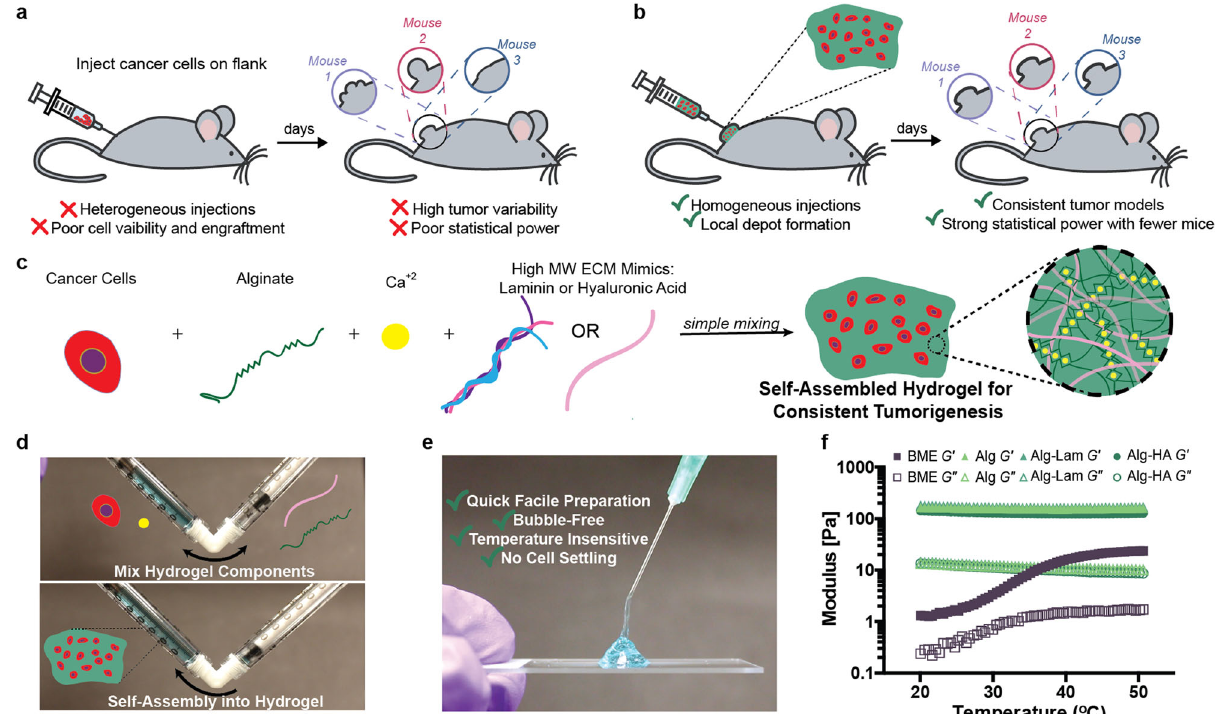
Fig. 1 Self-assembled hydrogels for preclinical tumor models. a Current method of forming syngeneic subcutaneous tumors by injecting cancerous cells in liquid saline. b Encapsulation process of B16F10 cells in self-assembled hydrogels and the bene fi ts of cell delivery using hydrogels. c Components that form self-assembled hydrogels including cancer cells, alginate, calcium, and extracellular matrix-mimicking biopolymers. d Dual syringe mixing strategy to formulate self-assembled hydrogels and encapsulate cells. A polymer solution containing alginate and ECM additives is loaded in one syringe (right) and cells and calcium sulfate are loaded into the second syringe (left). Blue dye is included to aid visualization for this demonstration. The two solutions are mixed with a female – female dual-syringe mixer by pumping the material back and forth for 30 s to form a robust hydrogel pre-loaded into a syringe ready for administration. e Injection of self-assembled hydrogels into a hydrogel depot through syringe needles (25G). f Oscillatory Shear Temperature ramp ( w = 10 rad/s, y =